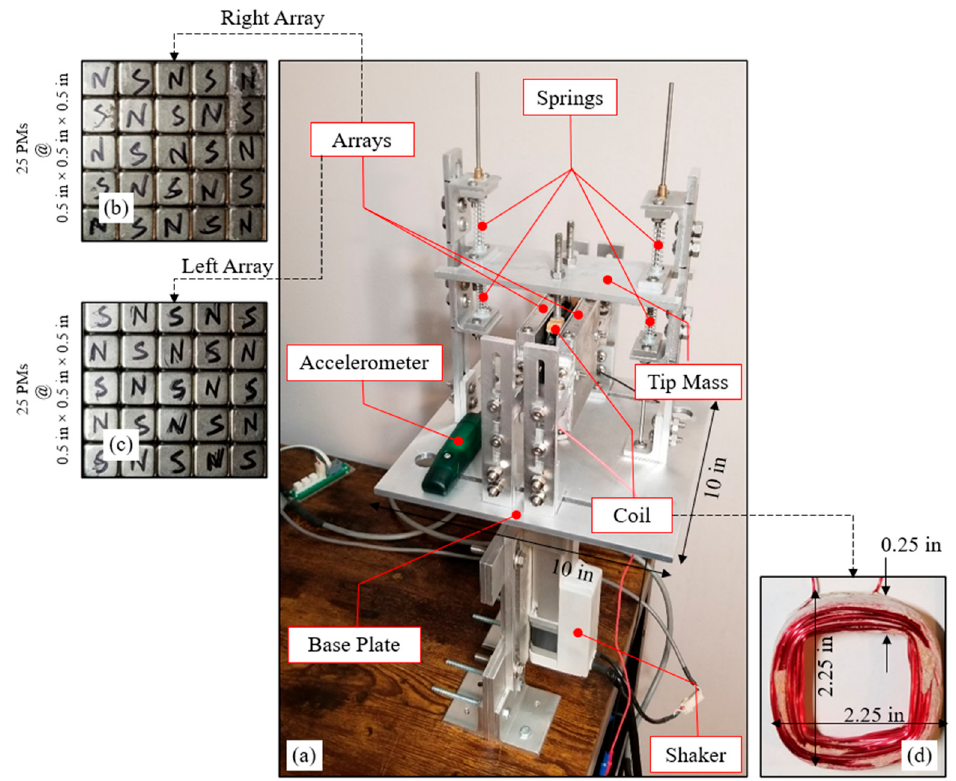
Figure 9. Proof-of-concept prototype of the EMEH; ( a ) 3D view of the fabricated device in laboratory with details of the geometry of ( b , c ) the arrays and ( d ) the copper coil.